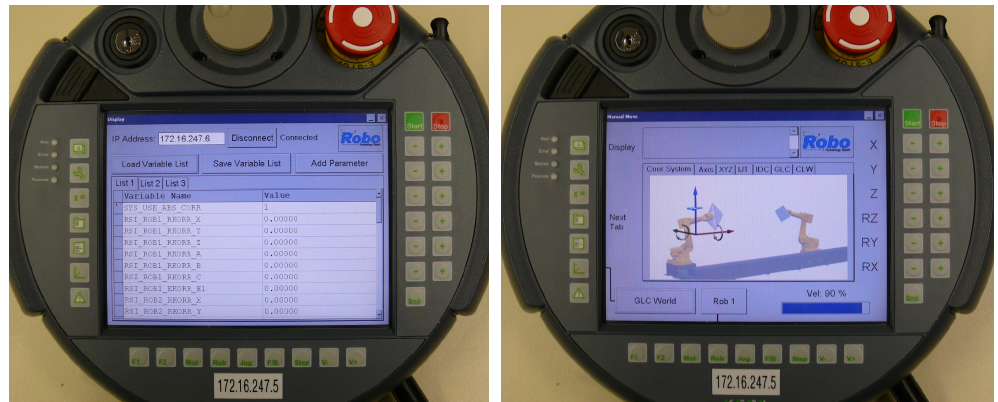
Figure 9: Manual Control Unit (MCU) - Numerical Display Window (left) and Graphical Visualization